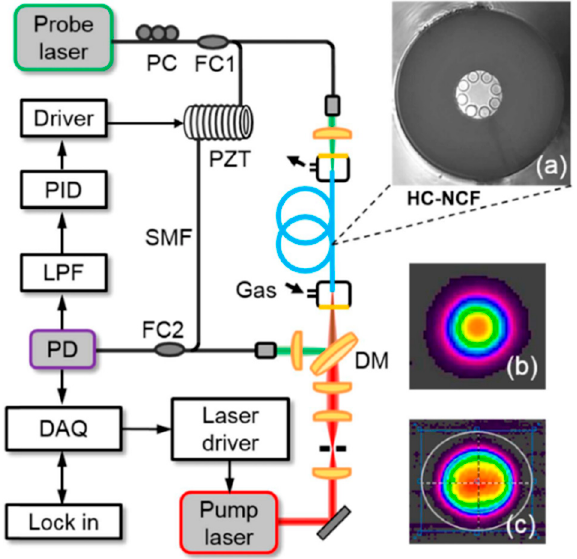
Figure 12. A schematic diagram of the photothermal interferometry (PTI) setup from [66]. A distributed feed-back (DFB) laser diode at 2.3 µ m was used as a pump laser. The interferometric measurement was performed at 1.55 µ m (pump laser). PD—photodetector, LPF—low-pass filter, and DAQ—data acquisition card. ( a ) shows an SEM image of the fiber, and ( b , c ) show the beam profile of the pump beam after and before passing through the hollow-core fiber (HC-NCF), respectively. Reprinted with permission from [66], © The Optical Society.